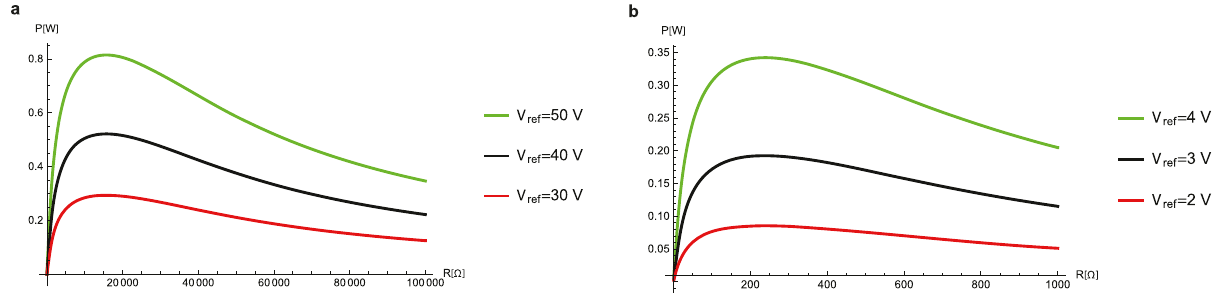
Fig. 7 The average power pro fi le against the electric load for different priming voltages. Curves are plotted for two different lubricating liquids: a PC and b IL, each presented for three different priming voltages. Parameters used: a N ¼ 10 2 , ω ¼ 3 : 5s (cid:5) 1 ; b N ¼ 10 3 ; ω ¼ 32s (cid:5) 1 .